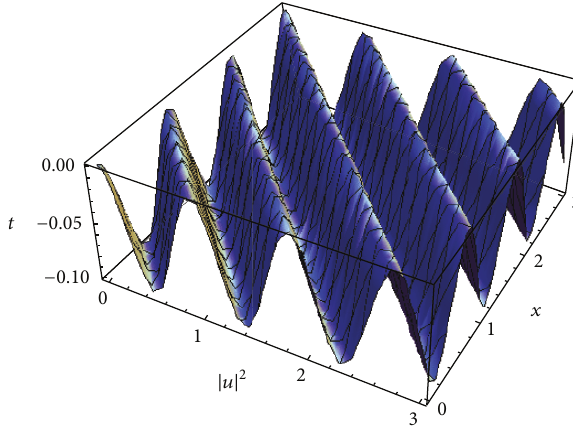
Figure 1: Profile of solution